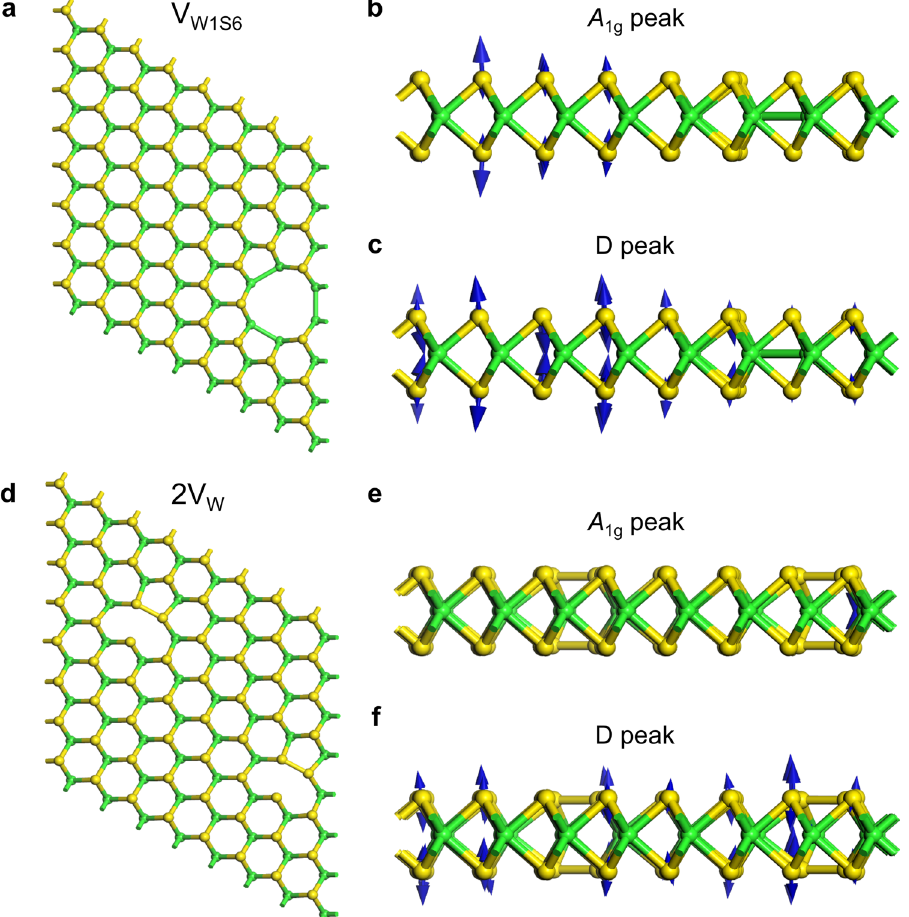
Fig. 5 DFT calculations for the Raman modes induced by V S-d and V W-d defects. a Complex vacancies model for 1 V W with 6 V S in the 8 × 8 unit cell. V W1S6 -induced vibrational modes for b A 1g and c D peaks. d Two single V W model in the 8 × 8 cell. 2V W -induced vibrational modes for e A 1g peak and f D peak. The blue arrows indicate the vectors for the atomic vibrations. The vector length does not indicate the Raman